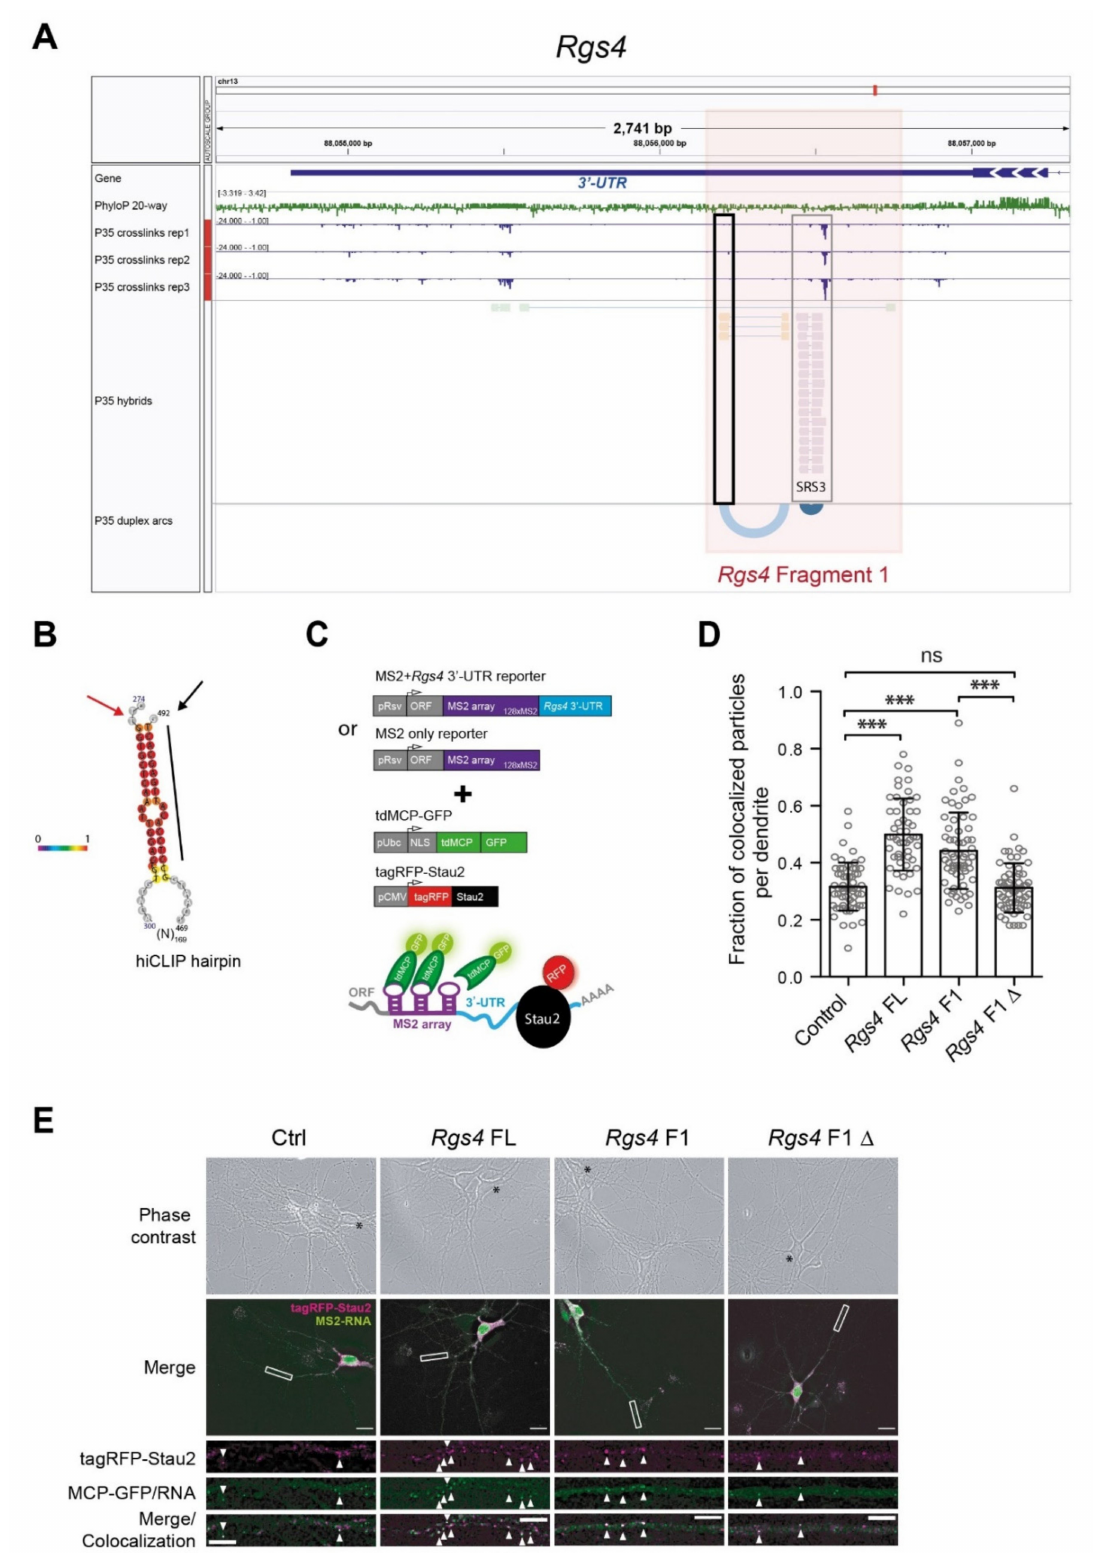
Figure 2. Rgs4 RNA duplex is sufficient to drive Stau2-ribonucleoprotein particle (RNP) assembly. ( A ) Coverage of Stau2- hiCLIP (P35 hybrids) and iCLIP (P35 crosslinks) sites in Rgs4 3 (cid:48) -UTR (blue, in 3 (cid:48) - to 5 (cid:48) -orientation as shown in integrative genomic viewer (IGV), reverse strand) is depicted together with the PhyloP (100 × vertebrates) sequence conservation (green) and the duplex linking arc plot. The 3 (cid:48) -UTR fragment 1 (pink shaded box) and fragment 1 deletion (black box) used in panels ( D , E ) are highlighted. ( B ) Display of the identified Rgs4 RNA duplex. Please note that in silico folding of Rgs4